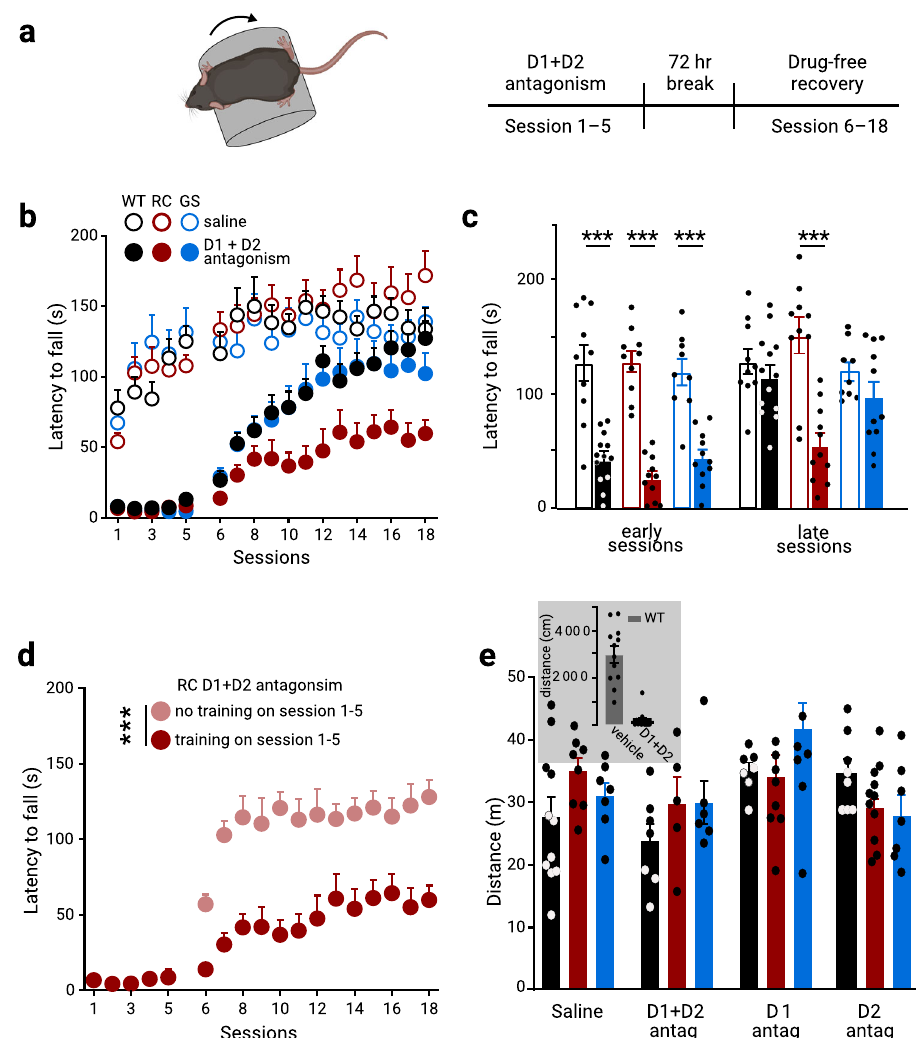
Fig. 3 RC KI mice show dopamine-dependent motor learning impairments. a Schematic of the rotarod training paradigm. Mice were assessed over a total of 18 daily sessions, where every daily session consisted of fi ve trials. WT, GS, and RC mice were administered either saline or a cocktail of D1 receptor (SCH23390) and D2 receptor (eticlopride), 1 mg/kg of each antagonist 30 min prior to daily sessions, and trained for fi ve successive days in an accelerated rotarod. After a 72 h break, the mice were returned to the rotarod for an additional 13 days of a drug-free recovery phase. b Genotype-dependent effect of blocking both D1 and D2 receptors during the fi rst fi ve sessions on rotarod performance of WT, RC, and GS mice. The average latency in the early (session 6 – 8) and late (session 16 – 18) stages in the drug-free recovery phase in b is summarized in c . Open and fi lled bars represent the average performance of saline control and drug-treated mice, respectively (saline treated groups: n WT = 10 mice, n RC = 10 mice, and n GS = 9 mice; D1 + D2 receptor antagonist treated groups: n WT = 13 mice, n RC = 11 mice, and n GS = 11 mice; *** p < 0.001 vs genotype-matched saline control). d Improved performance of RC mice Supplementary Table 7 for complete sample sizes and statistical results. e . Distance traveled in the open fi eld after fi ve days of rotarod training with either vehicle or dopamine receptor antagonist cocktail treatment. Another group of mice received dopamine antagonist treatment and rotarod training for fi ve days under the same schedule described in a-c and were tested in the open fi eld immediately after the 72-hr break instead of the drug-free phase (saline treated groups: n WT = 11 mice, n RC = 8, and n GS = 7 mice; D1R + D2R antagonist treated groups: n WT = 7, n RC = 5, and n GS = 6 mice; D1R